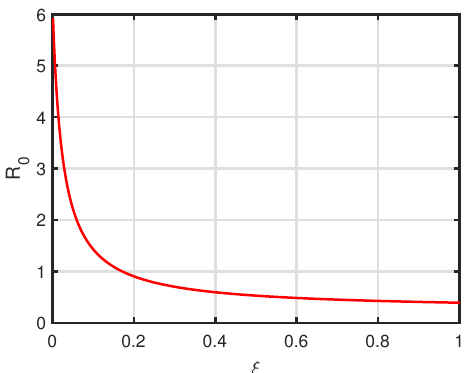
Figure 9. Variation of R 0 of system (3) with respect to φ while values of other parameters are taken from Table 3.